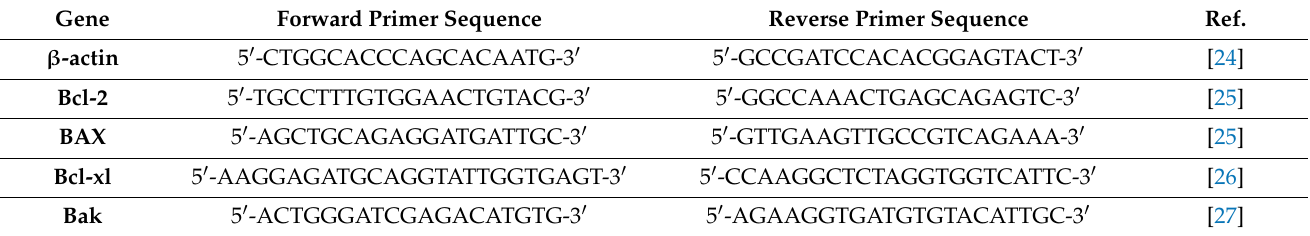
Table 1. Sequences of primers oligonucleotides used to amplify the studied genes. Gene Forward Primer Sequence Reverse Primer